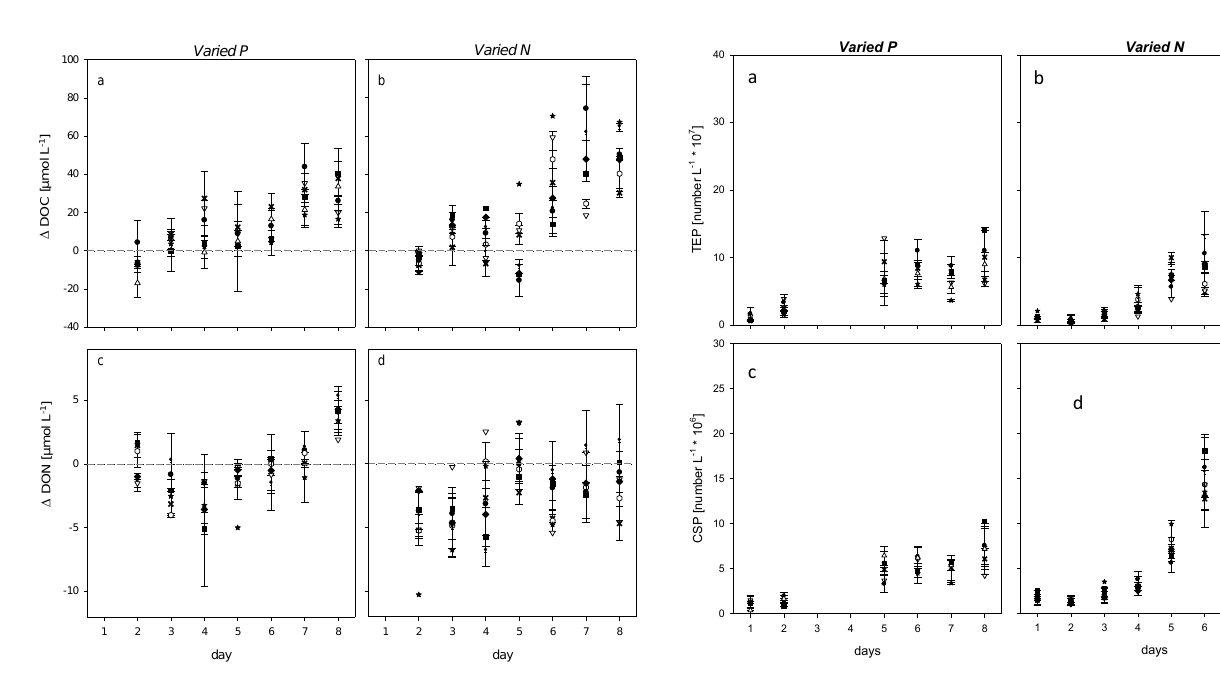
Figure 3. Changes in dissolved organic carbon ( δ DOC; a , b ) and dissolved organic nitrogen ( δ DON; c , d ) concentration during Var- ied P (a, c) and Varied N (b, d) . Values are given as difference to day 1. For treatments with identical nutrient supply, average values are given ± 1 standard deviation (error bars). The dashed line visualizes the zero value; symbols as in Table 1.